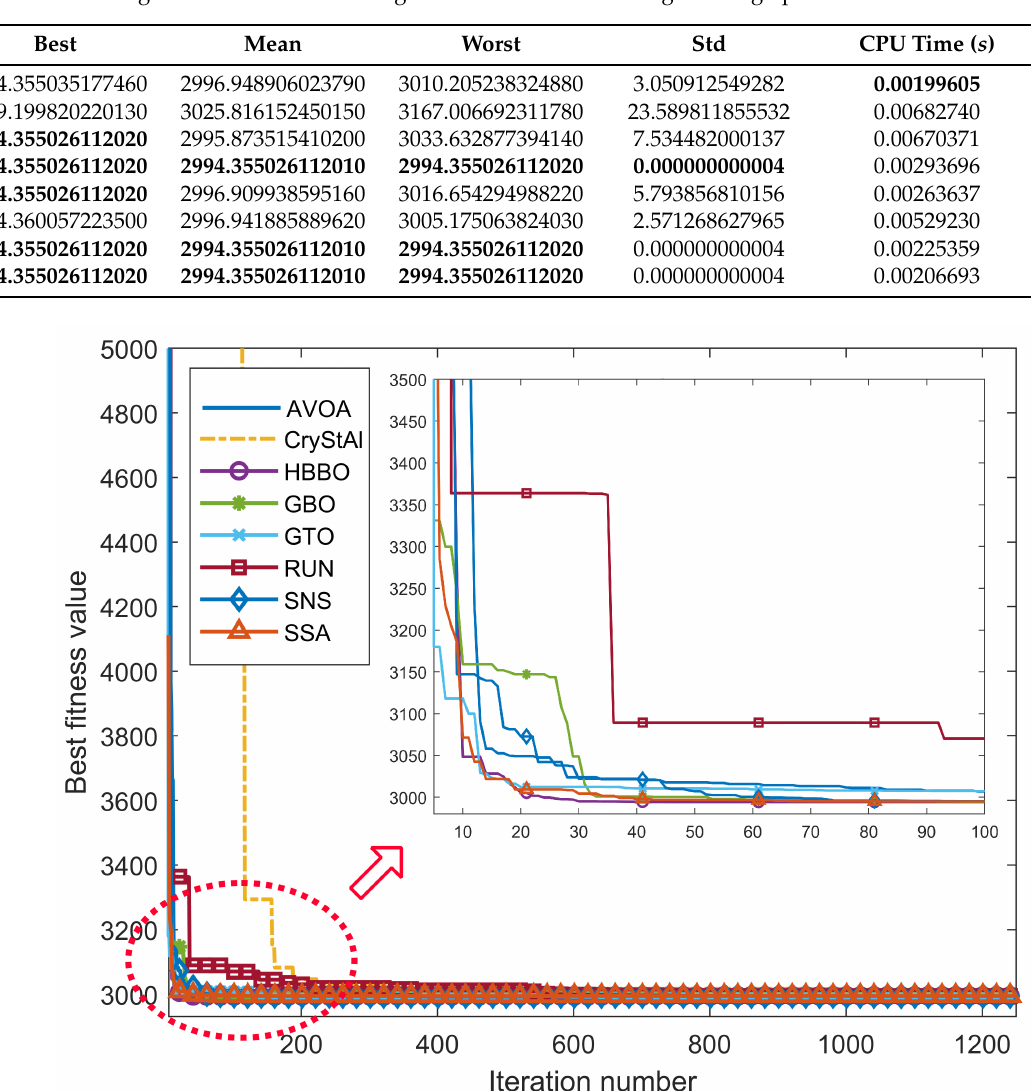
Table 8. Statistical findings of the bench-marked algorithms for the reduction gear design problem.